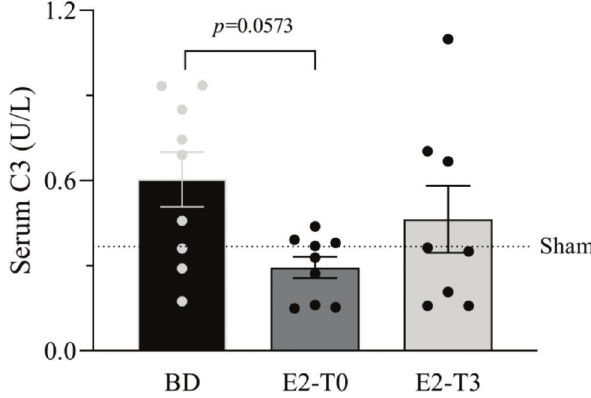
Figure 1 - Serum quantification of complement system C3 component. Female rats were separated in groups: sham animals as control, BD animals subjected to brain death (BD), E2-T0 animals subjected to BD and treated with 17 b -estradiol (E2) starting after BD confirmation, and E2-T3 animals subjected to BD and treated with E2 3h after BD confirmation. Data are expressed as mean ± SEM from 8-9 animals. Kruskal-Wallis p